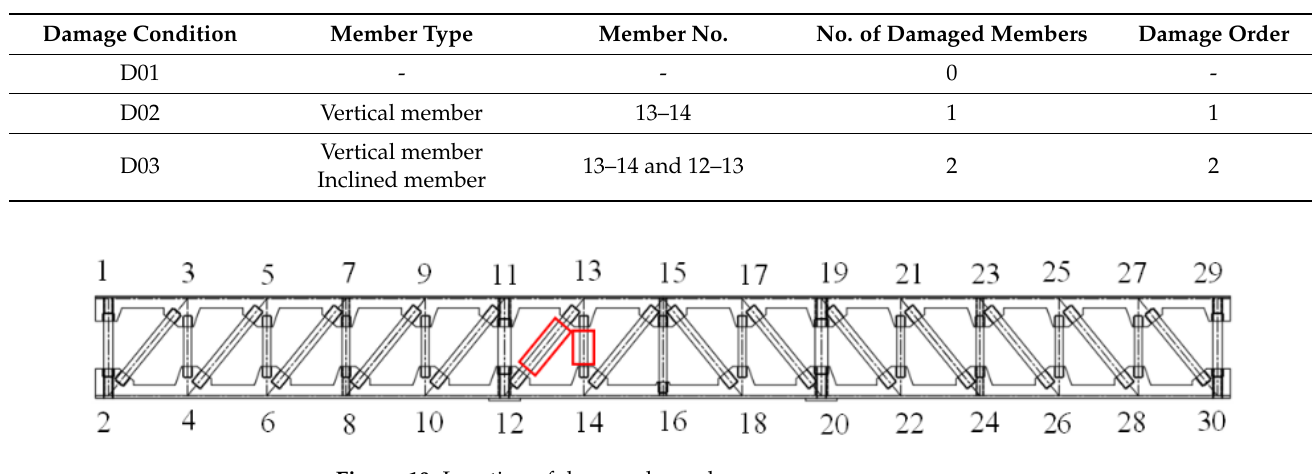
Figure 10. Location of damaged members.